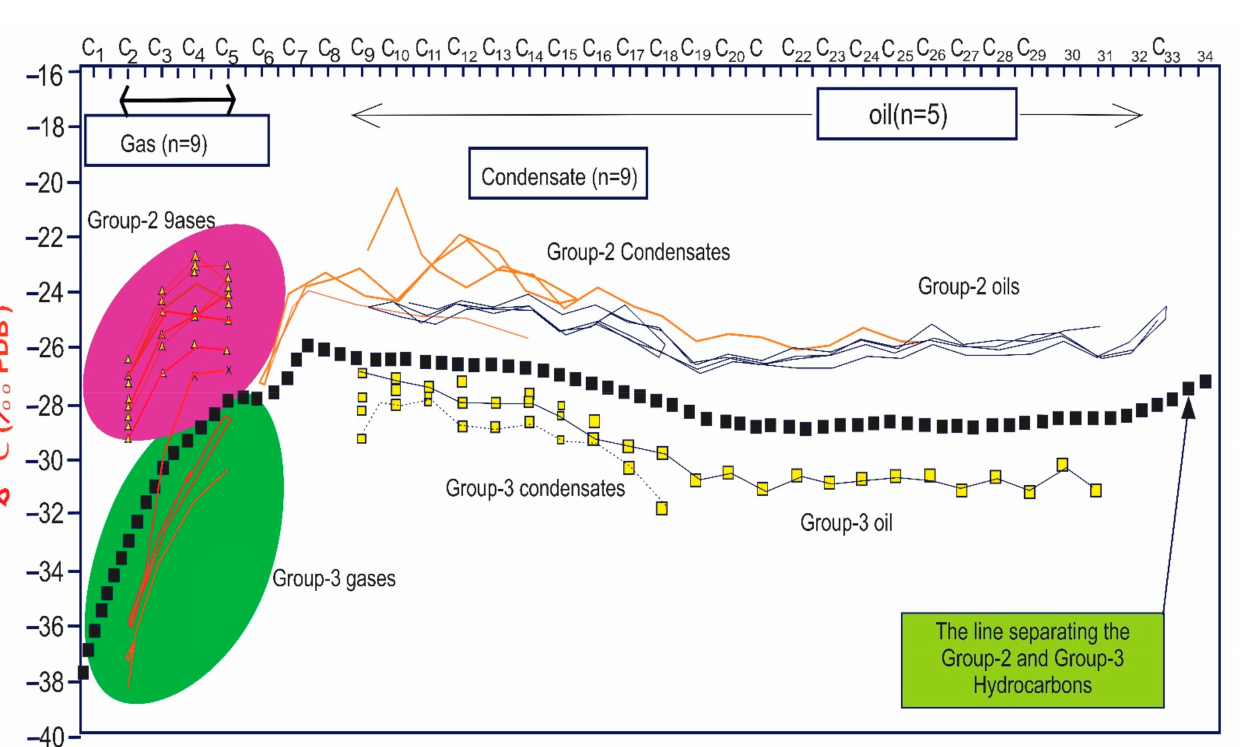
Figure 10. Plot showing the relationships between gases and condensates produced from the same formation (Reproduced from [155] with permission from